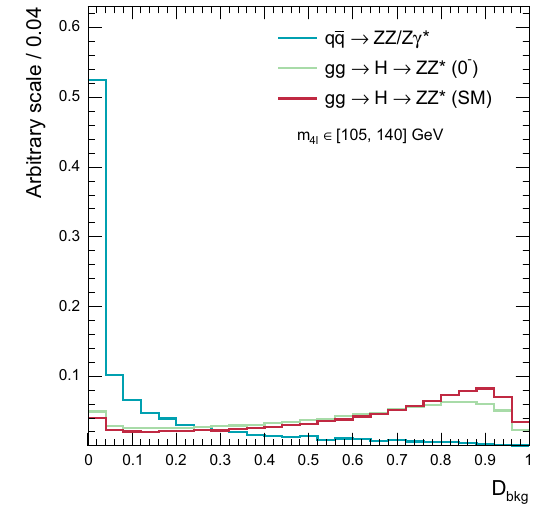
Fig. 1 Distribution of the D bkg (left) and D 0 − (right) variables for the gg → H → ZZ ∗ → 4 μ and q ¯ q → ZZ / Z γ ∗ → 4 μ processes, where the resonance H is taken to be the SM Higgs or a pseudoscalar of the same mass (0 − ). For the right-hand figure, we require D bkg > 0 . 5. Note